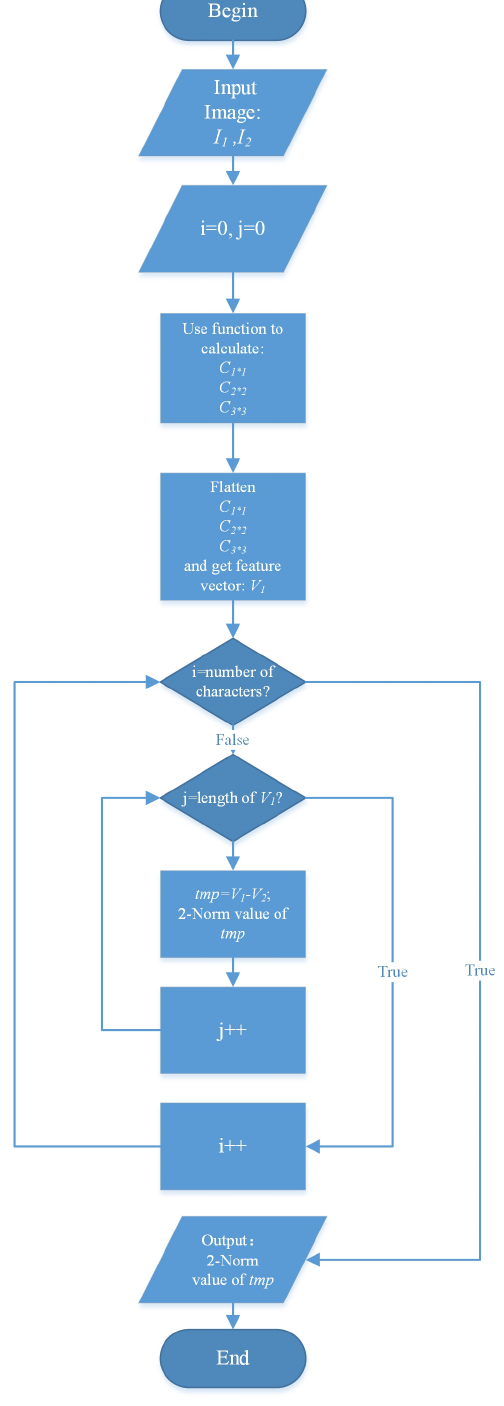
Figure 18. SPCPM